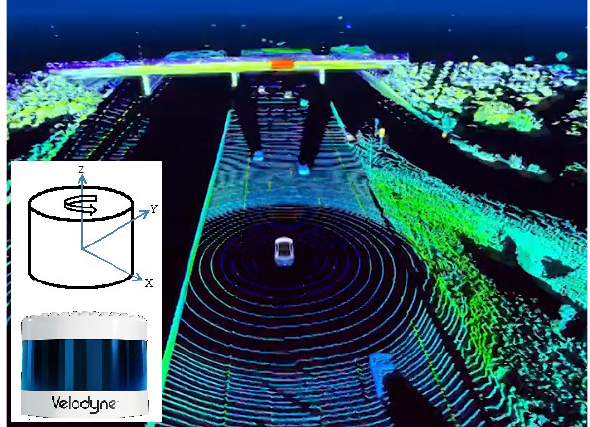
Figure 3. MBL coordinate axis and measurement data (partly